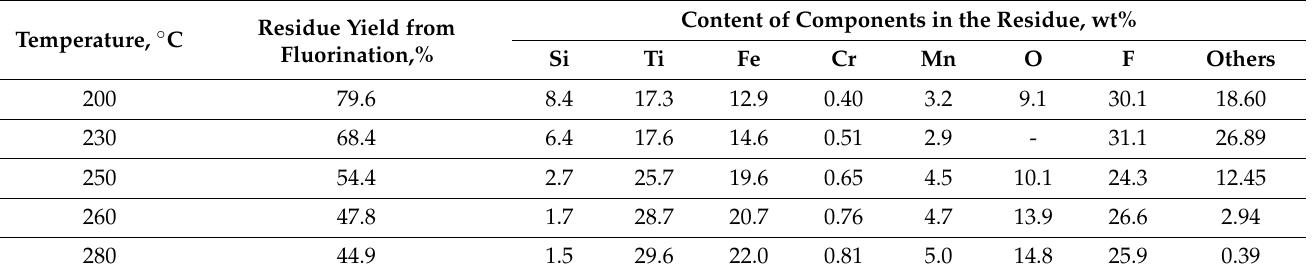
Table 2. Influence of fluorination temperature on the controlled elements content in the